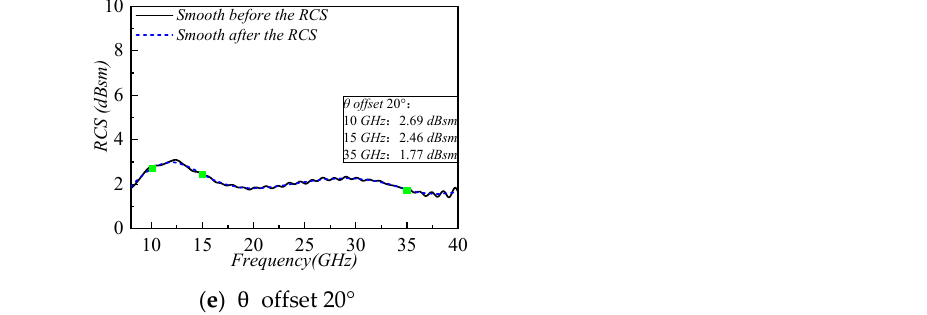
Figure 5. Simulation results of the loading TCR (side length a = 200) of the metasurface based on resistive film technology at various incident angles.